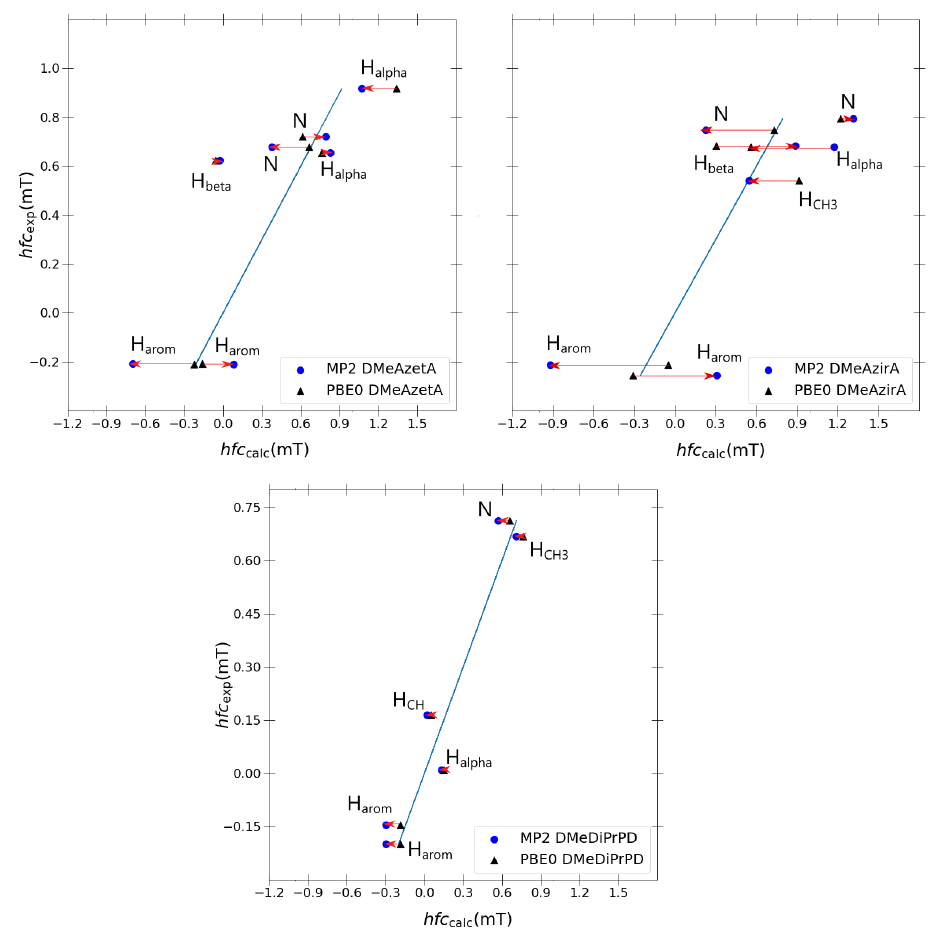
Figure 6. Individual PBE0 vs. MP2 hyperfine coupling constant comparisons for outlier molecules DMeAzetA, DMeAzira and satisfactory molecule DMeDiPrPD using the 6-31G(d,p)-J basis set. Fitted blue line in each graph is the ideal fit line for calculated results given as y = x